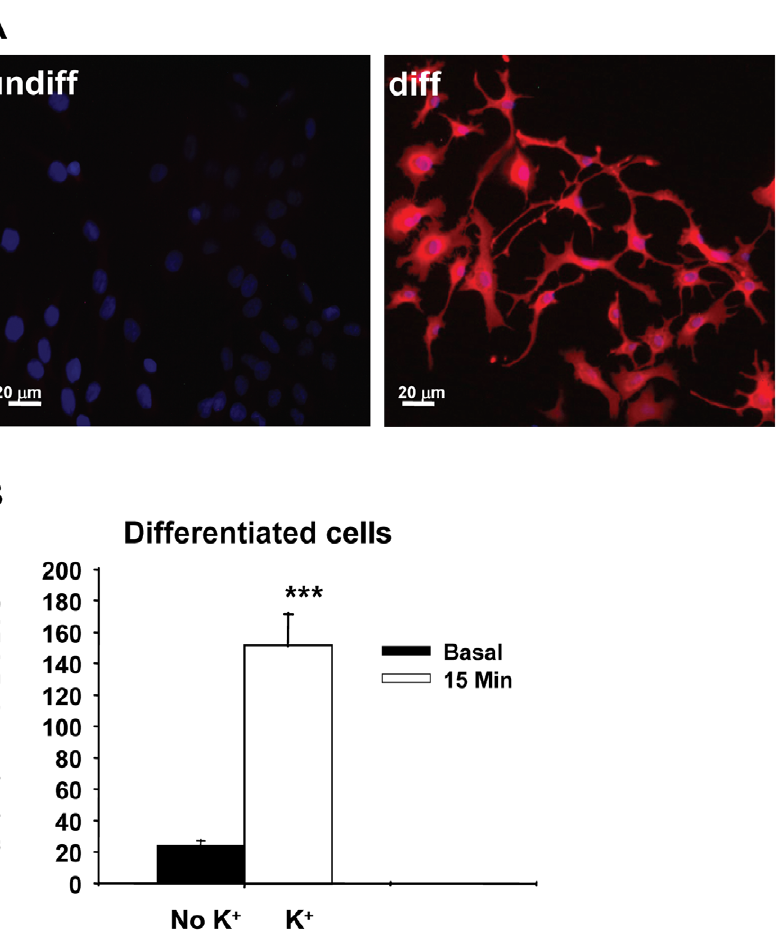
Figure 5. Synthesis of GABA and stimulation-induced release from differentiated HiB5 cells. ( A ) GABA was detected using a specific antibody against GABA. ( B ) GABA release was detected in artificial cerebrospinal fluid (aCSF) without KCl (basal) or with 100 mM KCl (stimulation) in the presence of Ca 2 + . GABA concentrations in aCSF were determined using HPLC. The data represent the mean 6 SEM for GABA release from 6 independent culture experiments (*** # 0.0004 vs baseline levels in differentiated cells).